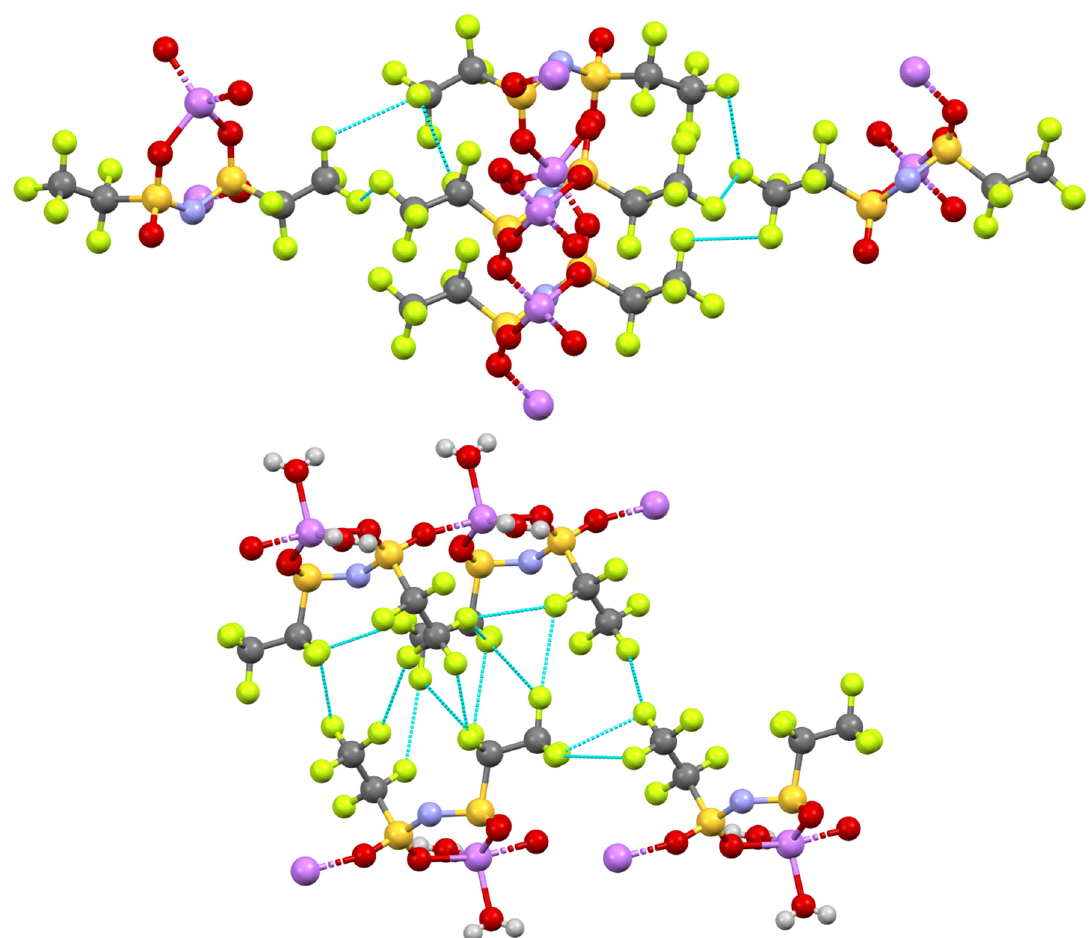
Figure 9. Depiction of the F ··· F interactions (light blue lines) in [Li{BETI}] ( top ) and [Li{BETI}(H 2 O) 2 ] ( bottom ). Table 2. Calculated interactions of atoms in both [Li{BETI}] and [Li{BETI}(H 2 O) 2 ] based on Hirshfeld surface